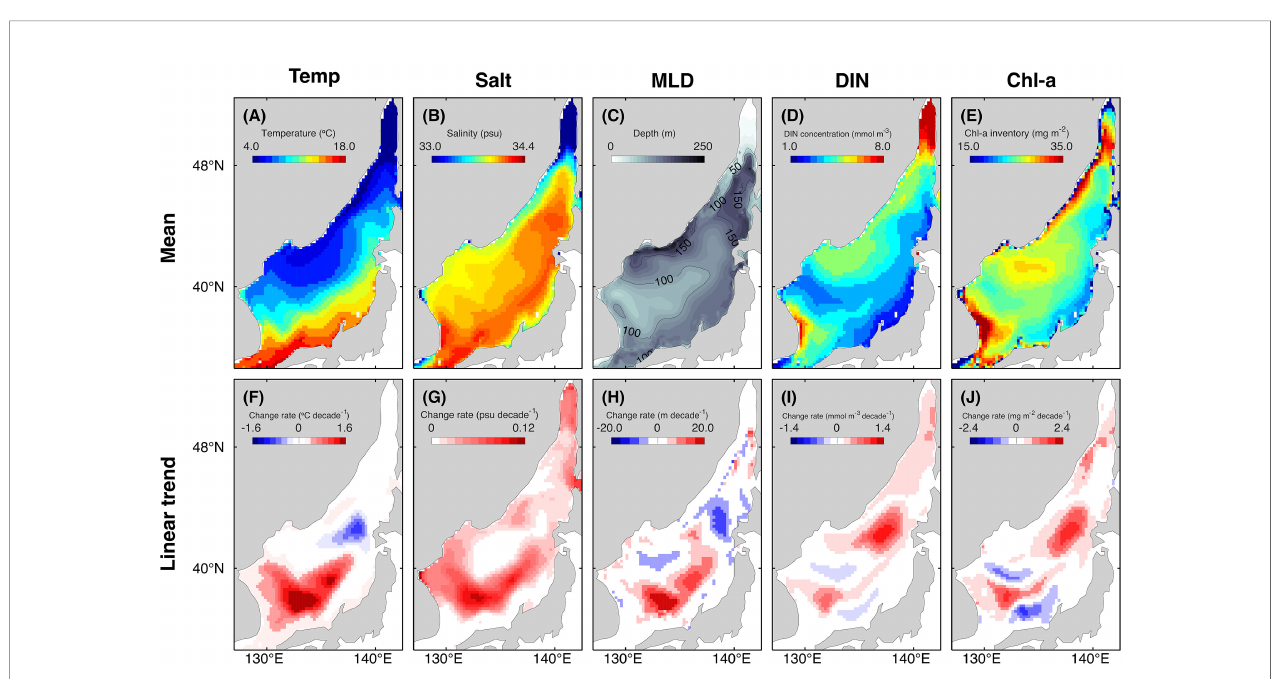
FIGURE 6 | Spatial distributions of the mean (upper panel) and linear trends (lower panel) of the control (CTL) experiment over the 36-year period (1980 to 2015): (A, F) temperature, (B, G) salinity, (C, H) mixed layer depth (MLD), (D, I) dissolved inorganic nitrogen (DIN) concentration, and (E, J) chlorophyll-a (Chl-a) inventory. Temperature, salinity, DIN and Chl-a patterns indicate the annual mean and are averaged from the surface to a depth of 110 m. The spatial patterns of the mean and linear trend of the MLD denote the average in the winter